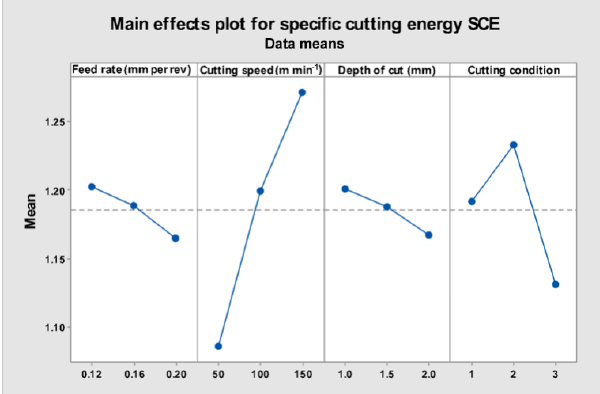
Figure 6. Main effects plot for SCE.